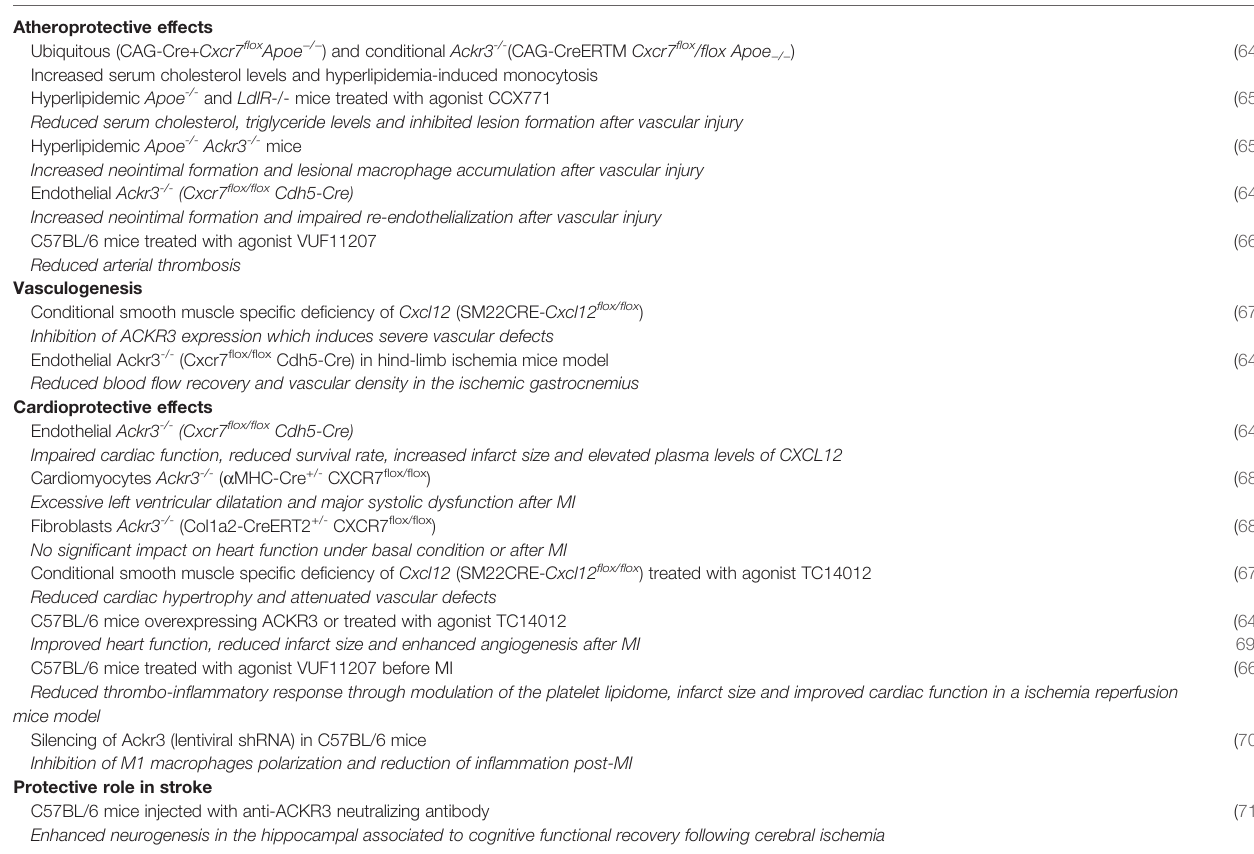
TABLE 2 | ACKR3 in cardiovascular